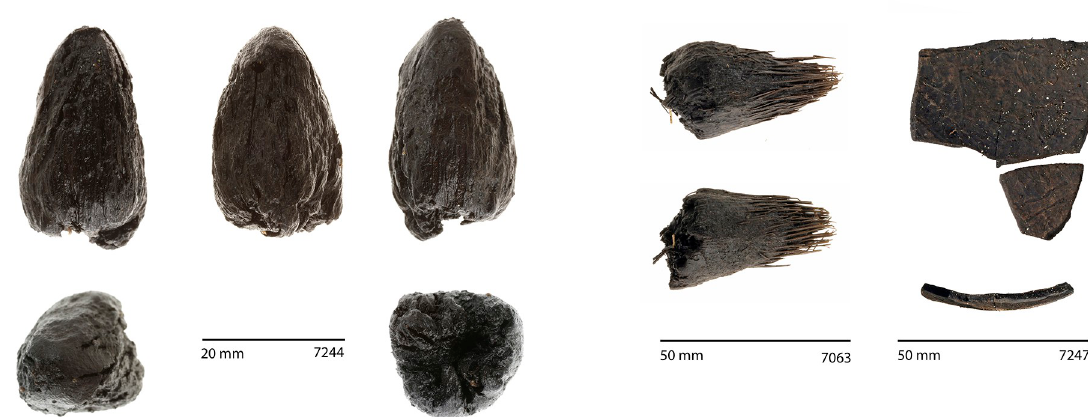
Fig 7. Examples of common macrobotanical materials. Left: immature Cocos nucifera fruit (five views); centre: Pandanus key (two views); right: Cocos nucifera endocarp (plan view and cross-section). (Photos by Tim Mackrell).